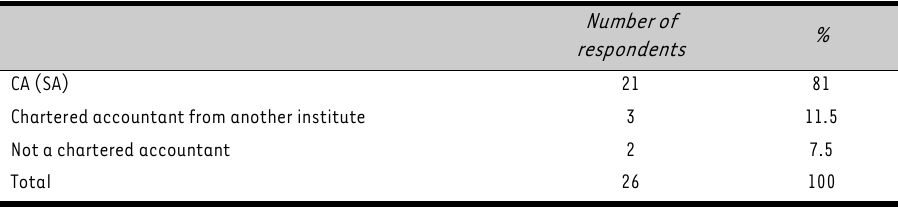
Professional designation of